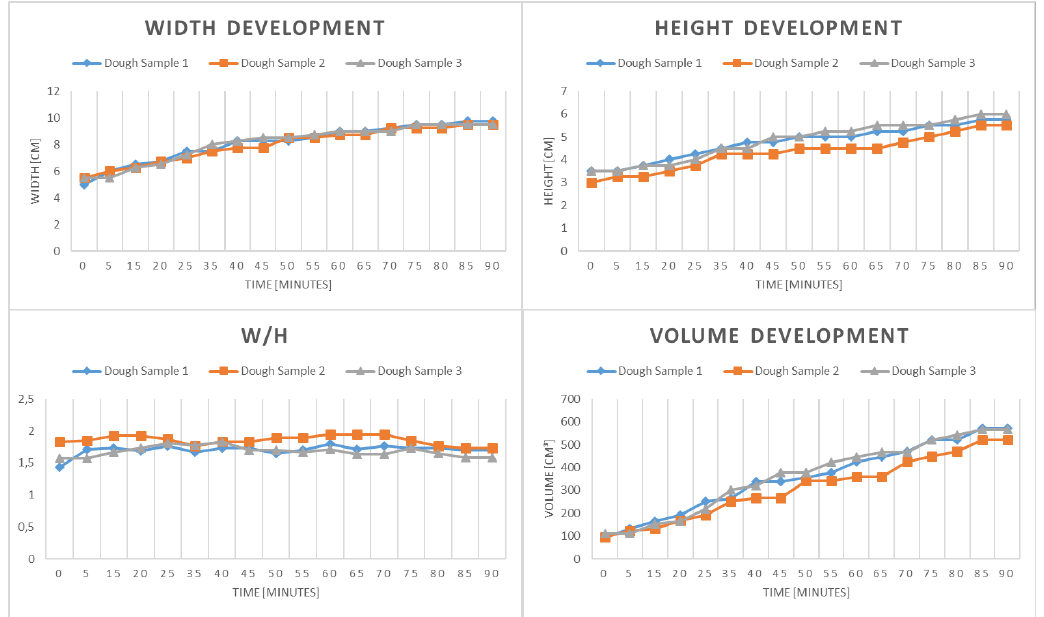
Figure 11. Course of width (upper left) and height (upper right) of three dough objects, the quotient W/h (lower left) and calculated volume (lower right).